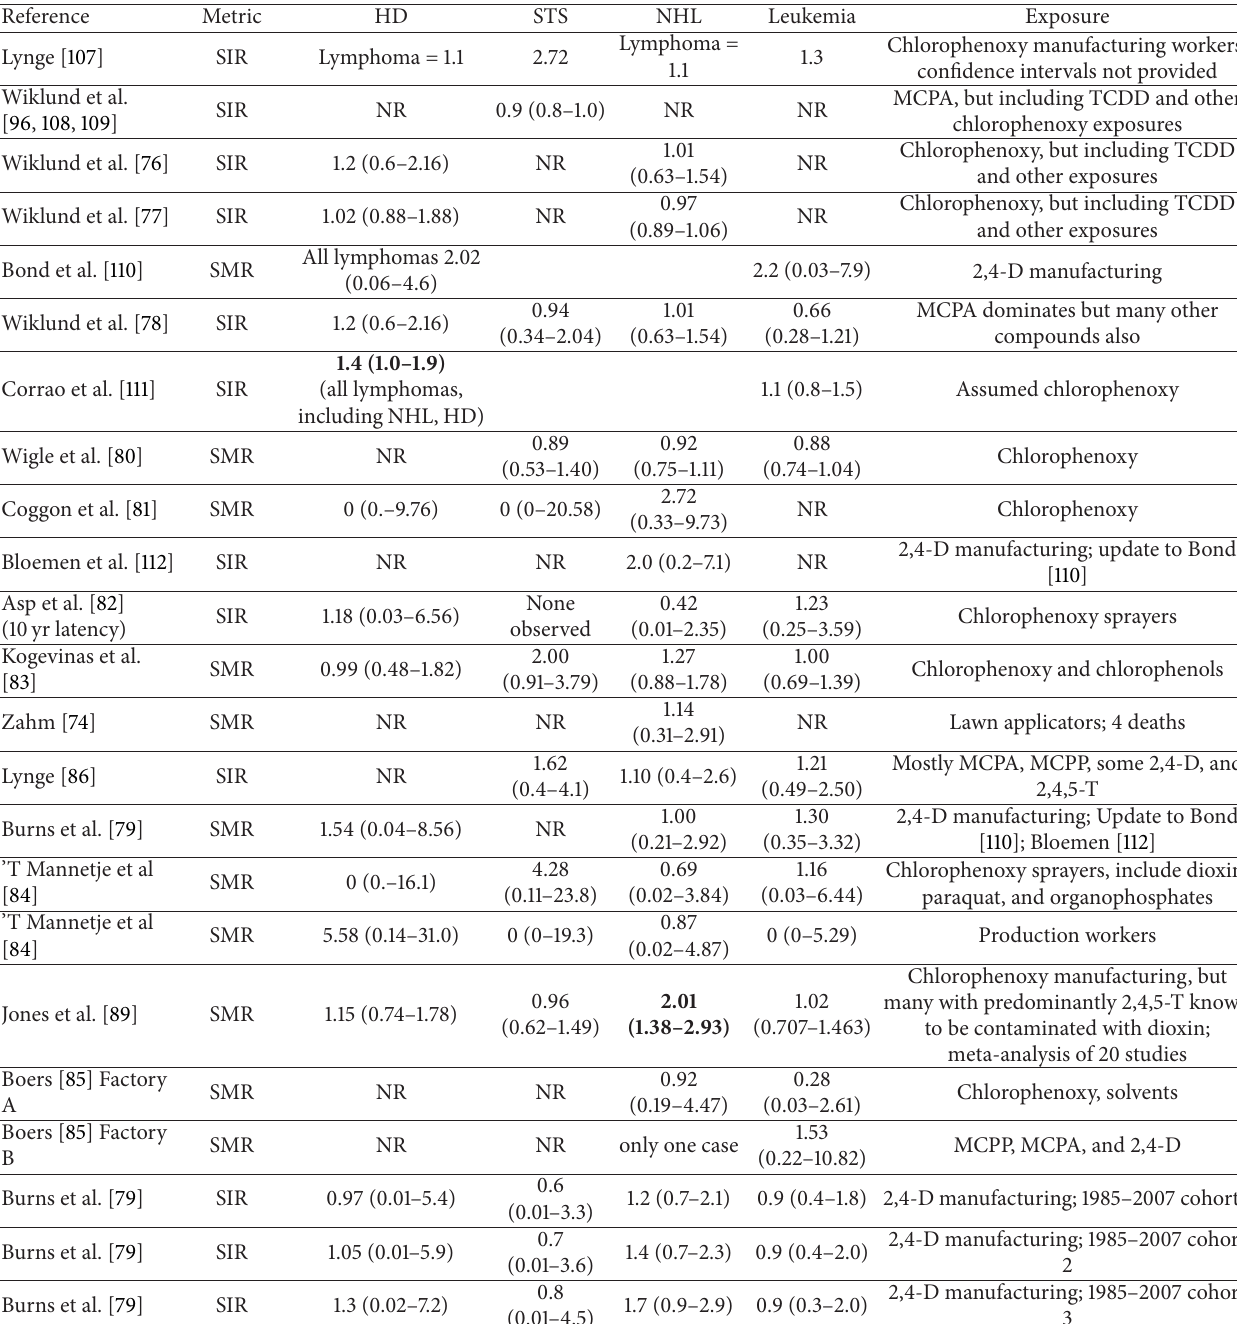
potential for exposure into high, low background based on their job titles. Overall mortality in the cohort was less than that expected from national death rates, as was mortality from all neoplasms, heart disease, and diseases of the respiratory system. Only one death from soft-tissue sarcoma occurred compared with one expected. Three men died from malignant lymphoma compared with nine